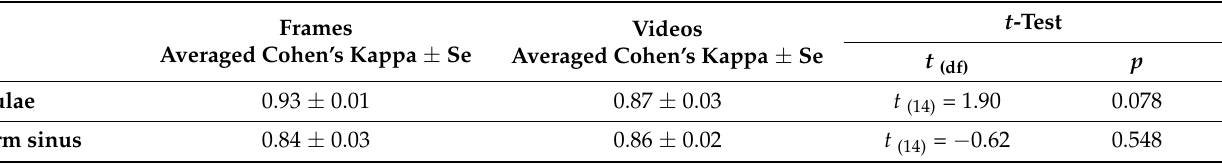
Table 4. Intra-rater reliability in frames and videos ratings across raters who assessed material twice (n = 15) for all consistencies (thin liquids IDDSI 0, pureed food IDDSI 4 and solid food IDDSI 7).